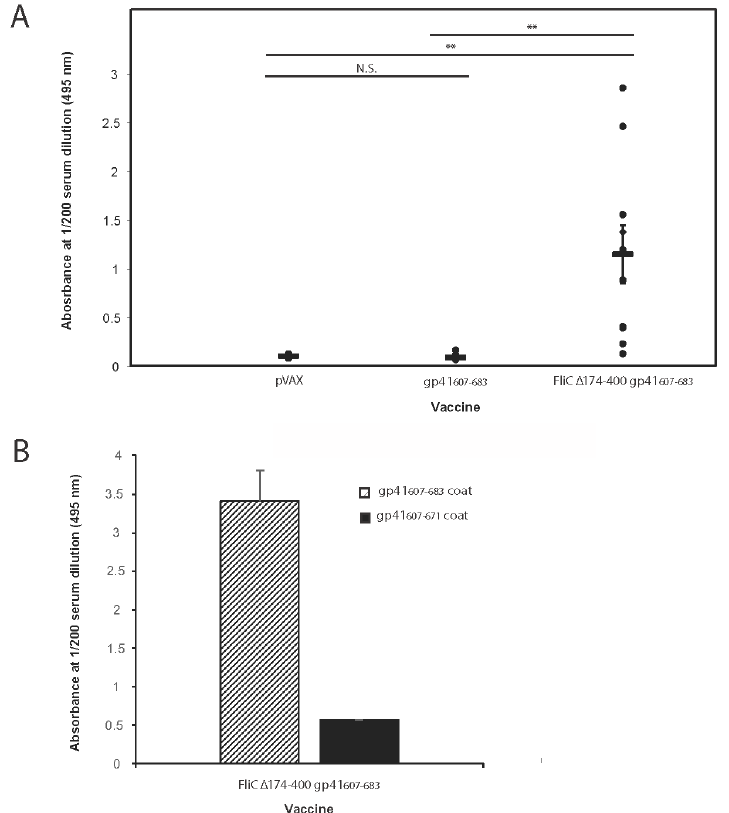
Figure 6. FliC Δ 174–400 augments HIV-1 gp41 607–683 immunogenicity. ( A ) Detection of HIV-1 gp41 607– Figure 6. FliC ∆ 174–400 augments HIV-1 gp41 607–683 immunogenicity. ( A ) Detection of